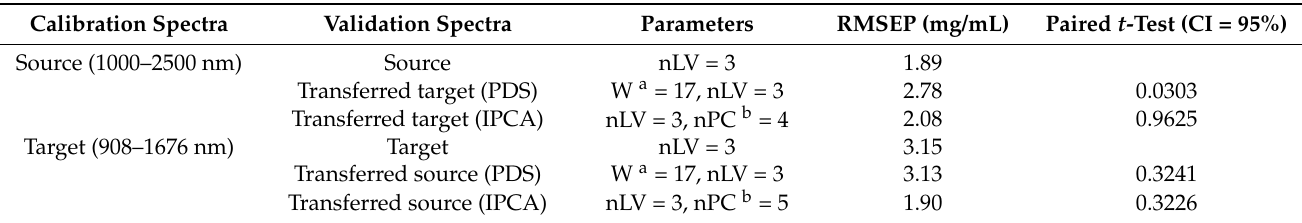
Table 4. Results obtained by PDS and IPCA for dataset 3 in whole spectral